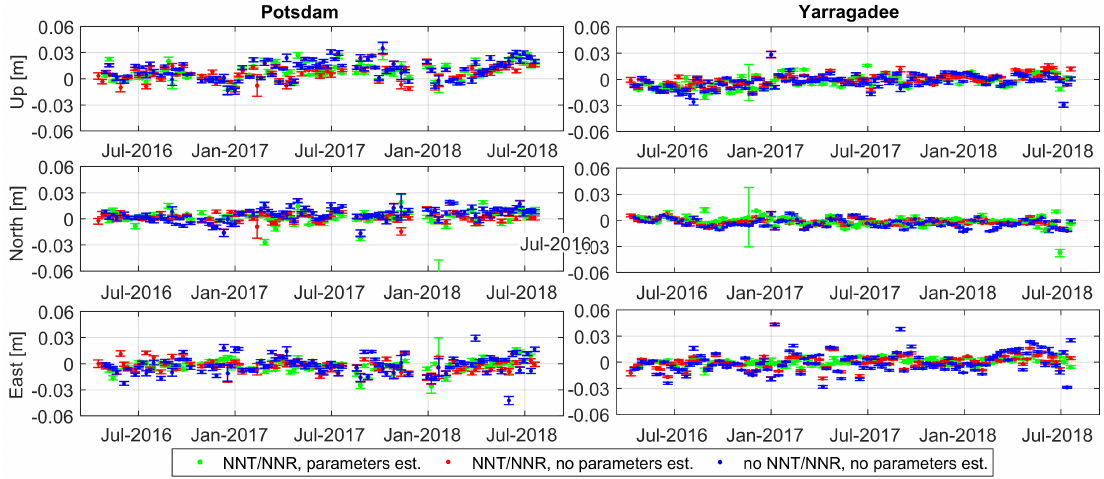
Figure 6. Time series (with error bars) of estimated station coordinates for Potsdam ( left ) and Yarragadee ( right ) using SLR observations to S3A/B w.r.t a priori SLRF2014 coordinates for scenario 1 (green), 2 (red), 3 (blue).